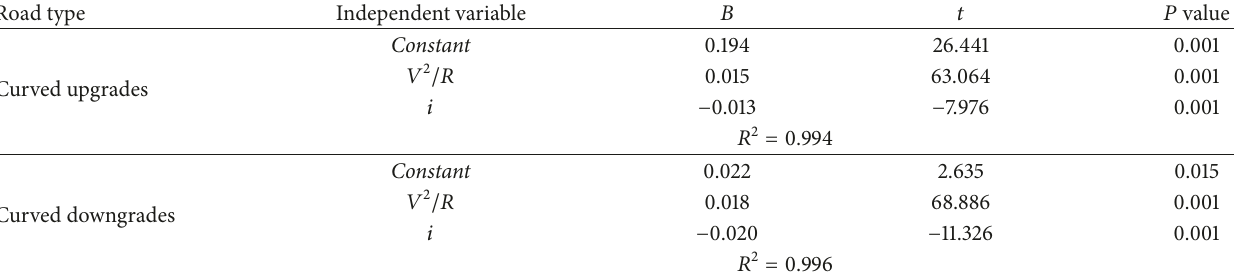
Table 8: Results of statistical analysis for 𝑓 𝐷 cornering on upgrades and downgrades.